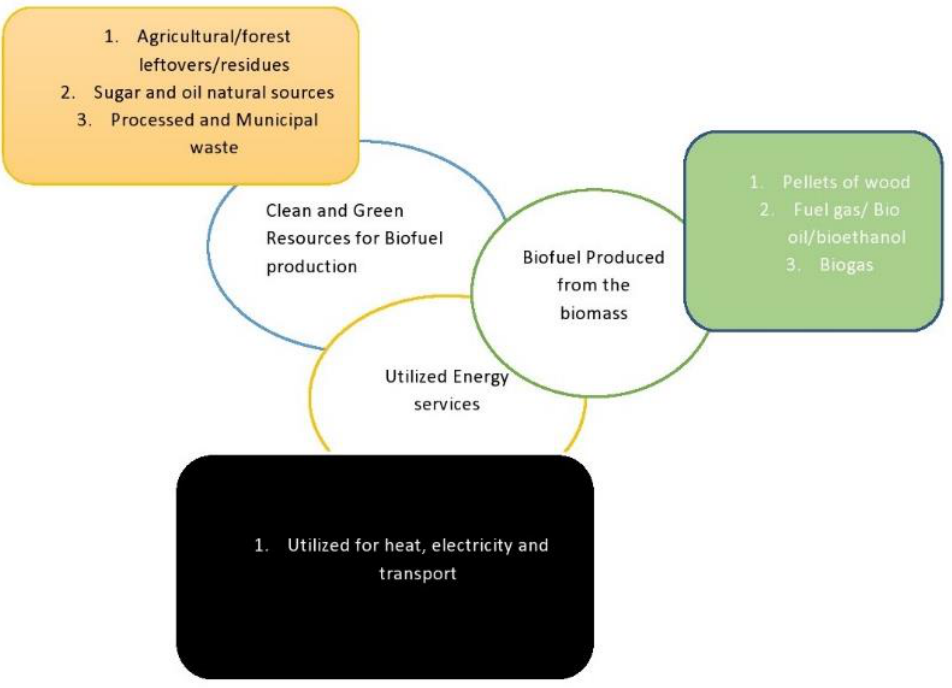
Figure 2. Biofuel production, its utilization as multiple energy sources, and the associated biomass resources.